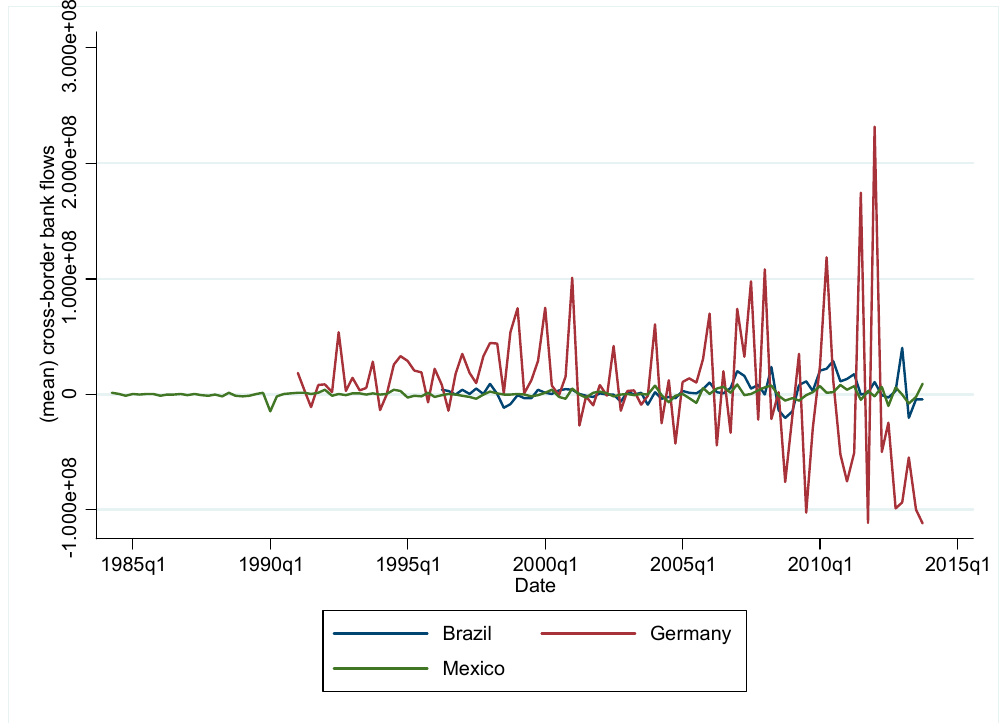
Figure A1. Cross-border bank flows: Germany, Brazil and Mexico.